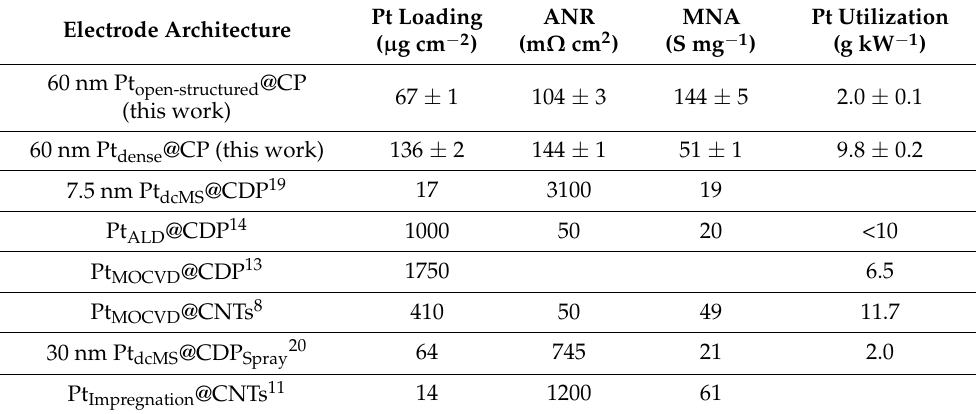
Table 2. Comparison of our membrane electrolyte assembly (MEA) performance to recently reported SAFC performance, including platinum loading per electrode, area-normalized resistance (ANR), mass-normalized activity (MNA) and power density-normalized platinum utilization (Pt use)